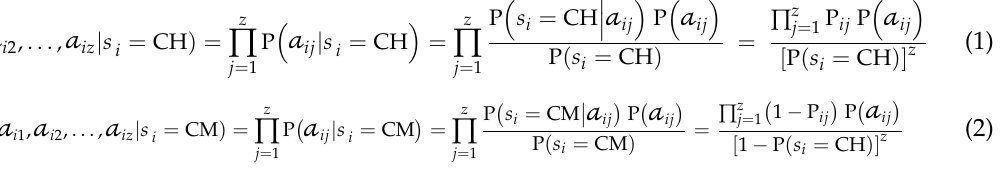
Figure 4. Dynamic clustering scheme.